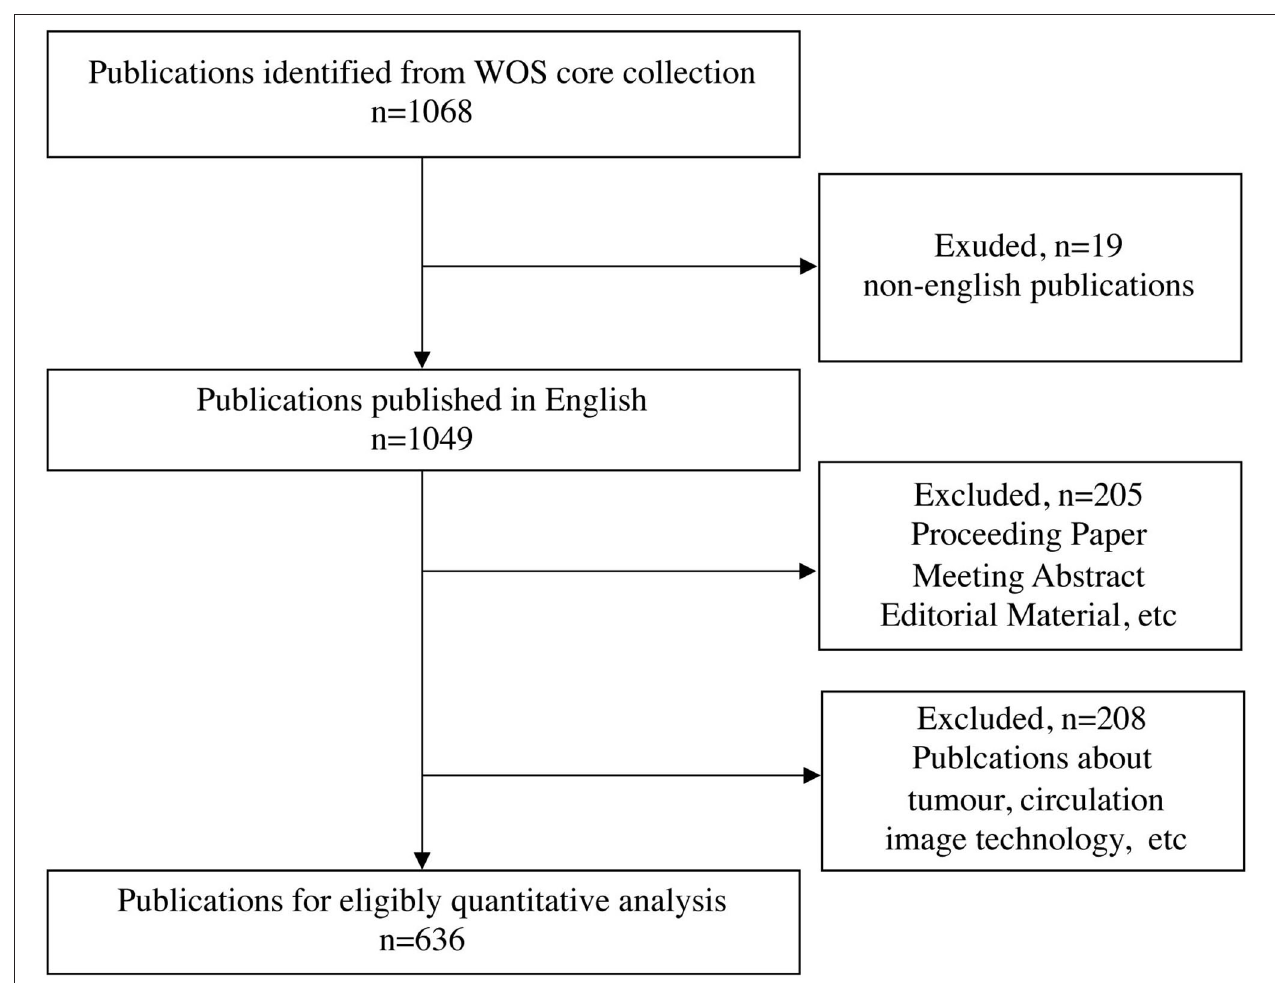
FIGURE 1 | Flow chart of included publications. WoSC, Web of science center.